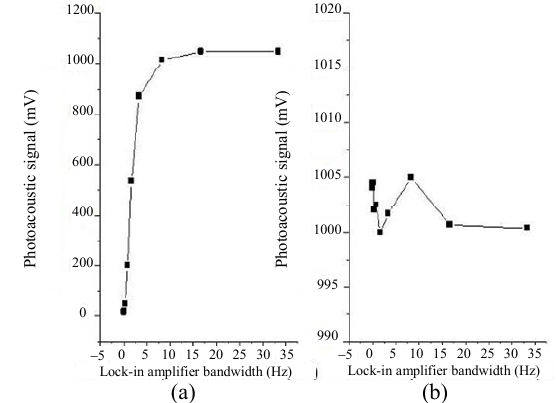
Fig. 5 Photoacoustic signal at different lock-in amplifier bandwidths: (a) photoacoustic signal with conventional WMS and (b) photoacoustic signal with new wavelength calibration